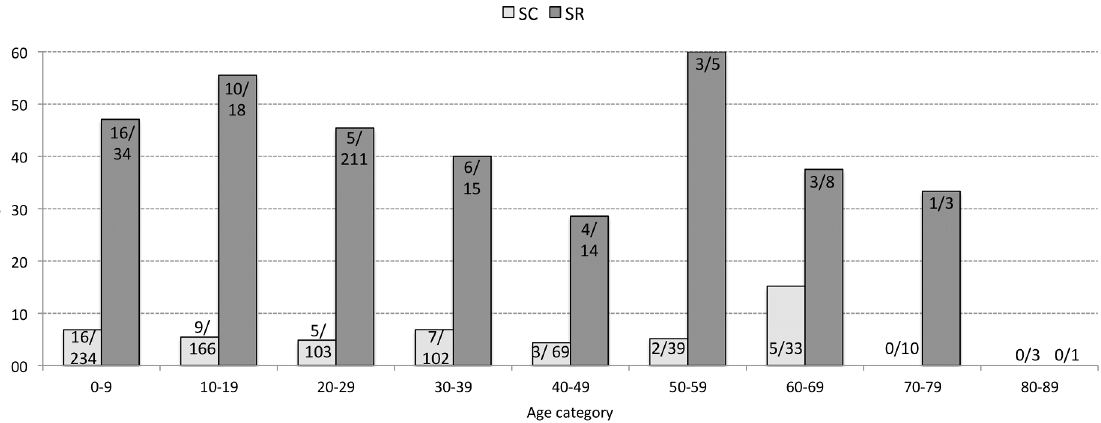
Figure 4. Sero-antigen conversion and -reversion in function of age categories for Period 3. SC and SR stand for seroconversion and seroreversion,